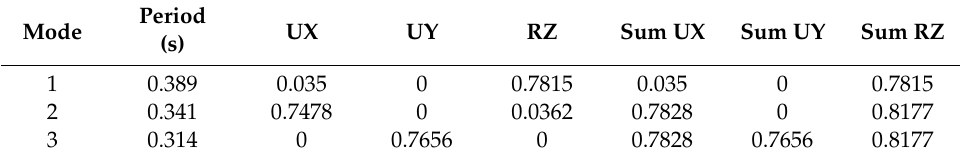
Table 13. Ratios of the modal participating mass before the reducing of the torsion.